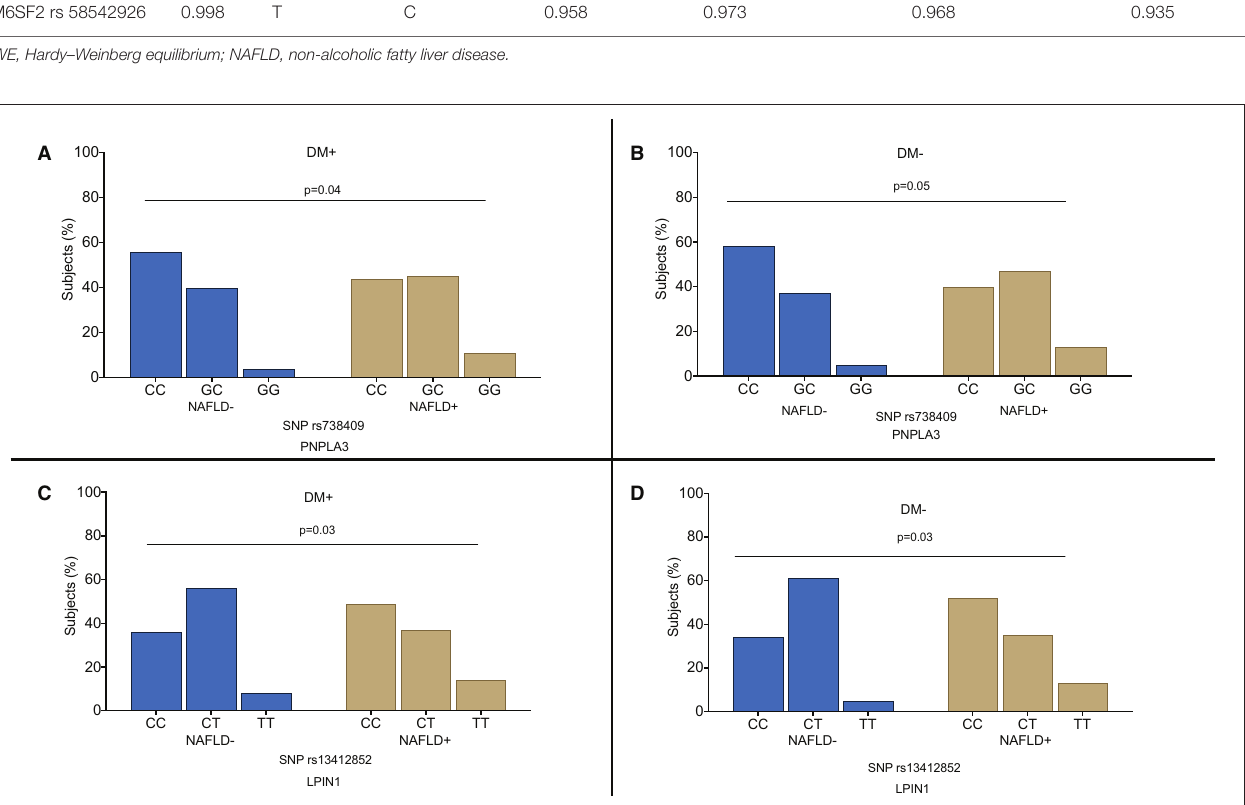
was associated with significantly higher liver stiffness values compared with the CC and CG genotypes (GG: 13.9 ± 8.2 KPa;